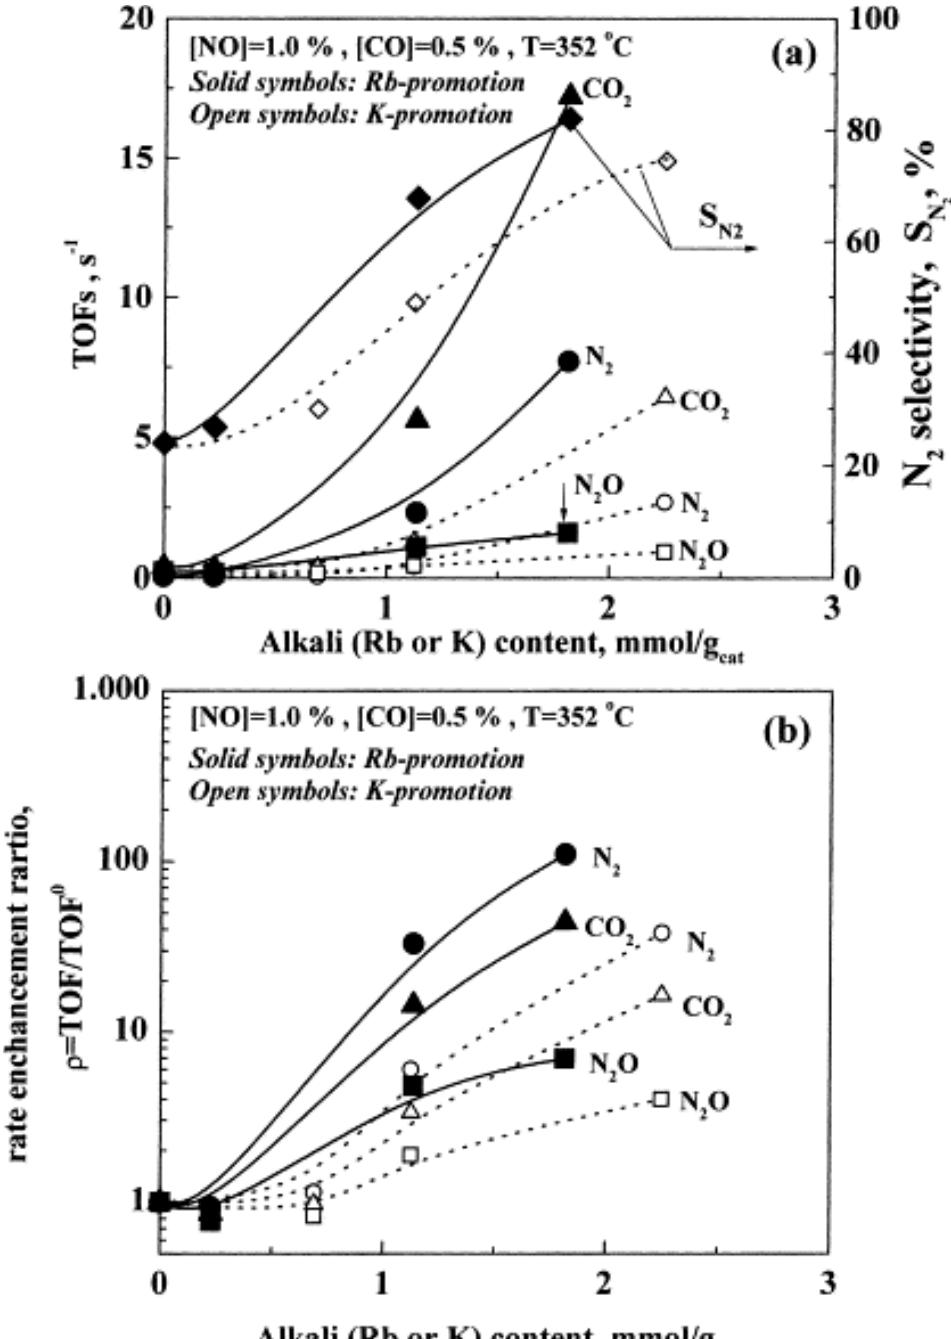
Figure 10. ( a ) Effect of Rb or K content of Pt/ γ -Al 2 O 3 catalyst on the turnover (TOF) formation rates of N 2 , CO 2 and N 2 O and on N 2 -selectivity at T = 352 ◦ C, [NO] = 1%, [CO] = 0.5%. ( b ) Corresponding enhancement ratio ρ = TOF/TOF 0 values. Solid lines and symbols refer to Rb-promotion, dashed lines and open symbols refer to K-promotion. (Reprinted with permission from Ref. [53]; Copyright 2001, Elsevier).